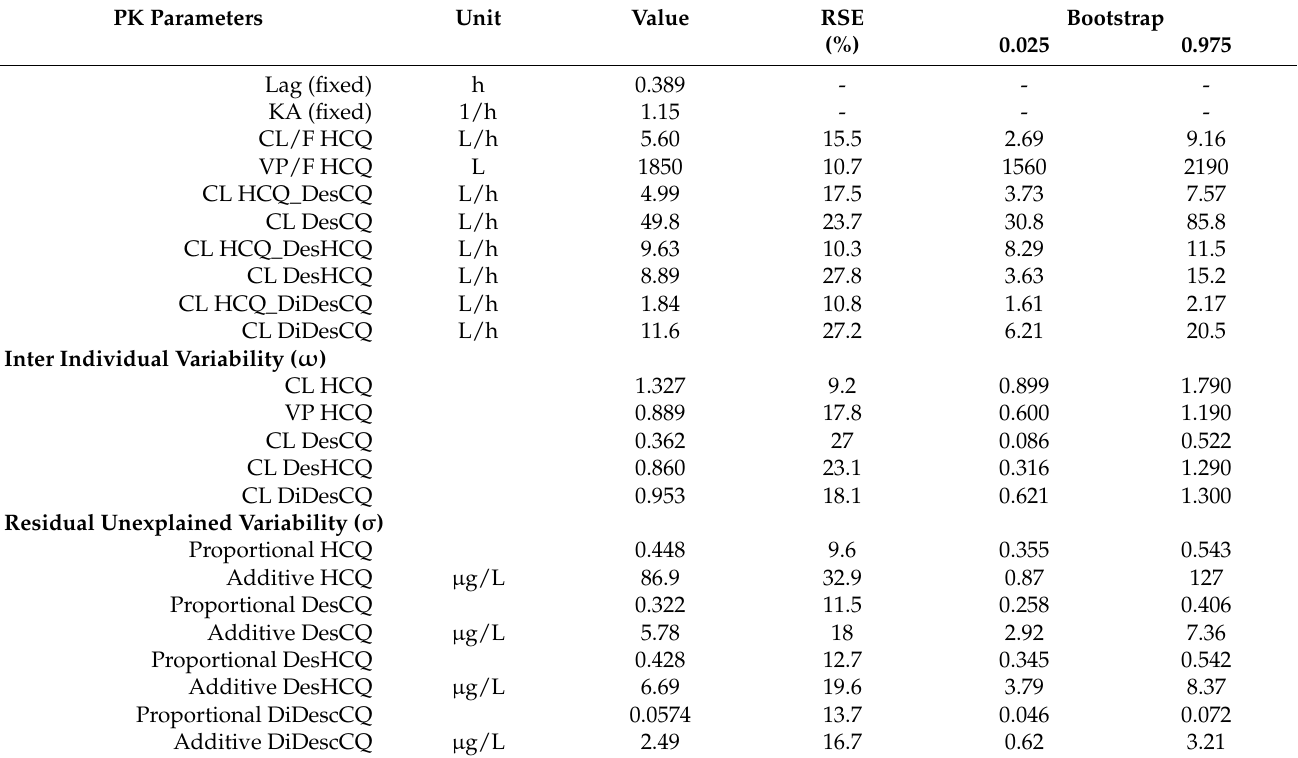
Table 2. Population pharmacokinetic parameters of hydroxychloroquine and its